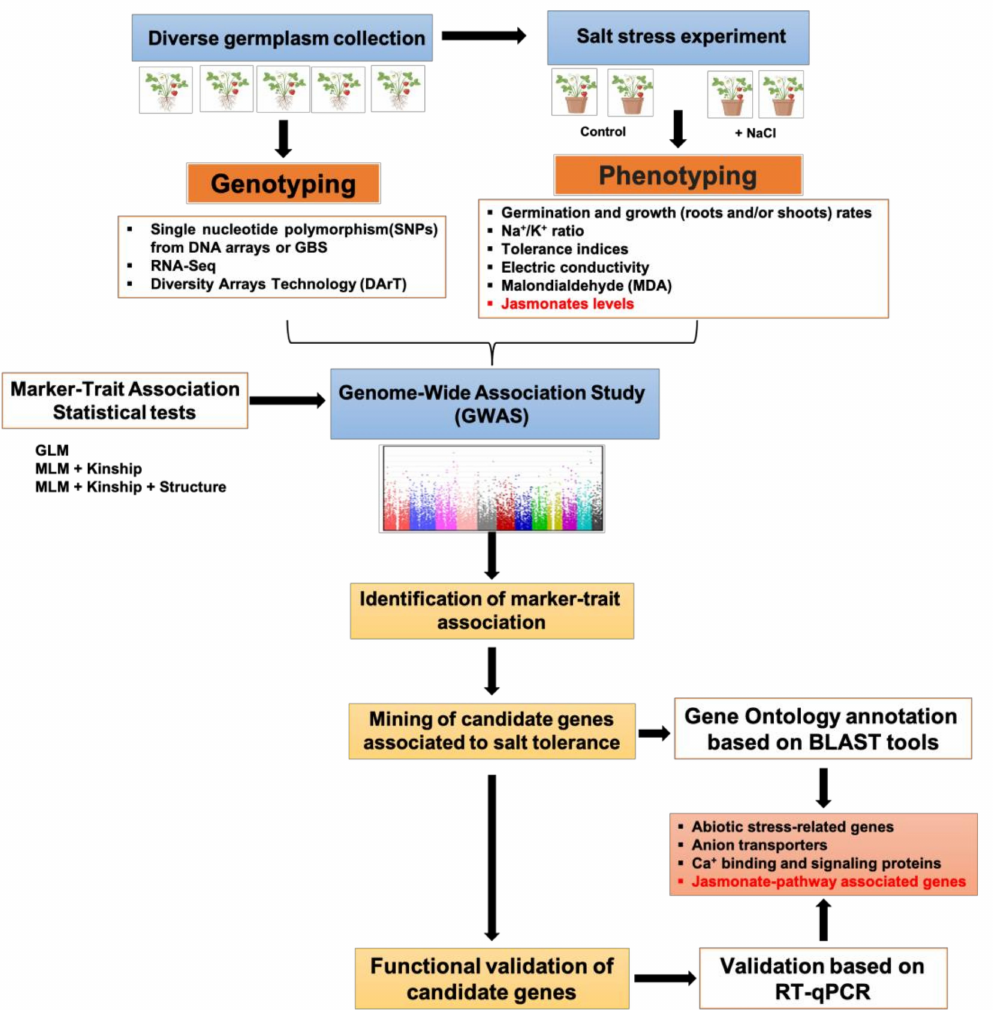
Figure 2. Genome-wide association study (GWAS) pipeline to identify jasmonate pathway-associated genes involved in the salt stress response and salt tolerance in crops. GBS, SSI, GLM, and MLM correspond to genotyping by sequencing, salt stress index, general linear model, and mixed linear model, respectively. For more details, see the